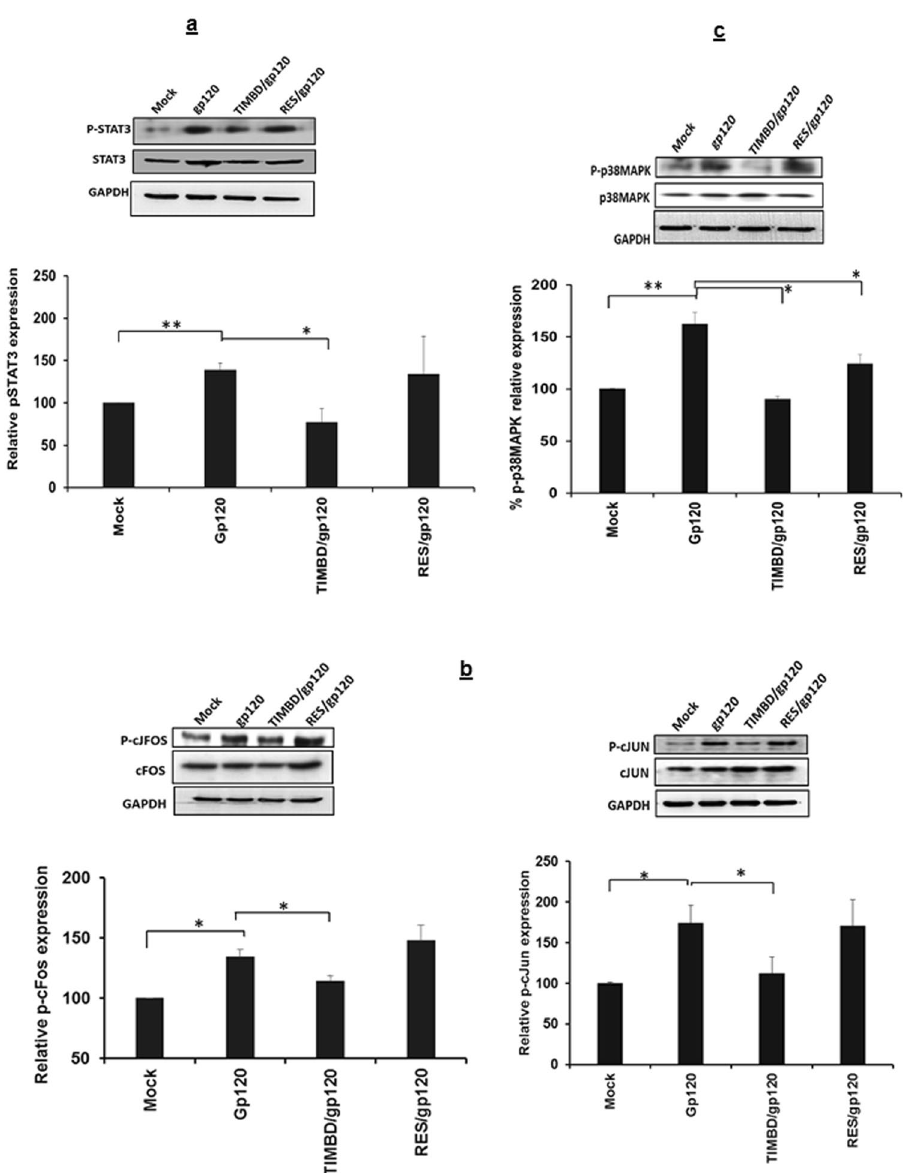
Figure 4. TIMBD inhibits protein expression levels of phosphorylated AP1 and STAT3 in SVG astrocytes. SVG astrocytes were treated with 50 µ M TIMBD 1 h prior to transfection, then transiently transfected with plasmid encoding HIV-1 gp120 for 6 h. Protein expression levels of phosphorylated STAT3 ( a ), phosphorylated c-Jun and phosphorylated c-Fos were measured ( b ). The protein expression levels of phosphorylated p-38MAPK were determined following treatment of SVG astrocytes with 50 µ M TIMBD 1 h prior to transfection with plasmid encoding HIV-1 gp120 for 1 h ( c ). The blots represented in the figures were obtained by cutting the membranes at molecular weight markers covering proteins of interest before probing them for primary and secondary antibodies. Each bar represents mean ± SE for 3 independent experiments, with each experiment done in triplicate and the western blots are representative images. One-way anova was used for statistical analysis and statistical significance is denoted as * (p-value ≤ 0.05) and ** (p-value ≤